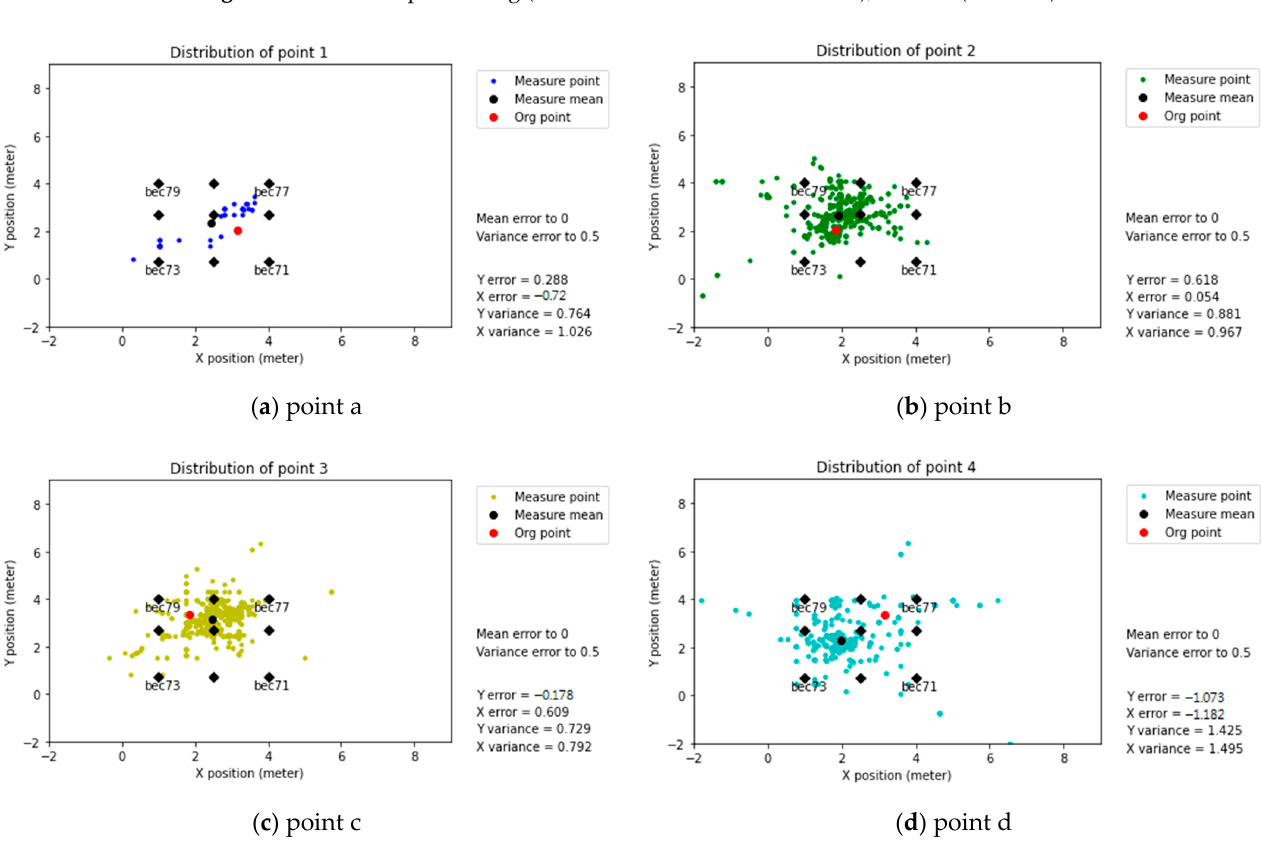
Figure 18. Predicted positioning (with modification coefficients), BLE 5.0 (Nano